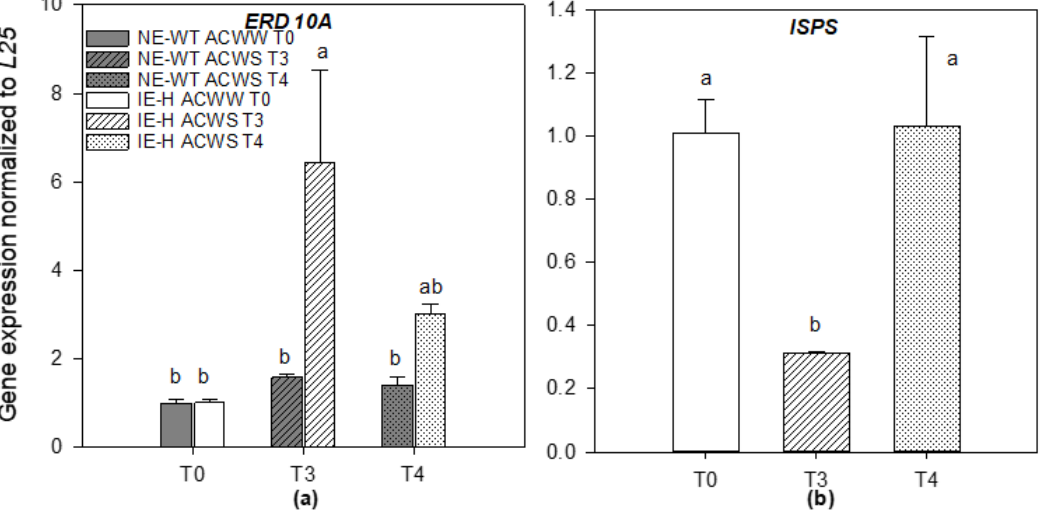
Figure 3. Expression of NtERD10A and ISPS genes in actual climate conditions. ( a ). Expression of the dehydrin NtERD10A gene was measured in non-emitting wild-type = NE-WT (grey) and iso- prene-emitting line = IE-H (white) at different time points (T0: full color; T3: striped; T4: dotted). Levels from NtERD10A were normalized against L25 in each treatment. ( b ). Expression of ISPS gene was measured in IE-H line in each treatment. Levels from ISPS were normalized against L25 in each treatment. Means ( n = 3) + SE are shown. A one-way ANOVA followed by a Tukey’s test was per- formed to define the statistical significance ( p < 0.05) of differences among means across the treat- ments. Different letters show statistically significant differences.